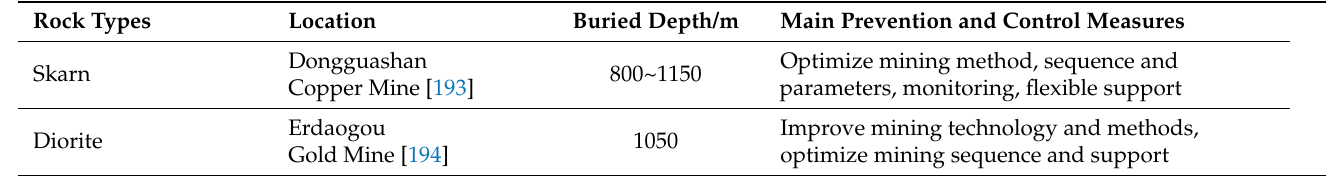
Table 9. Rockburst prevention and control in different locations and rock